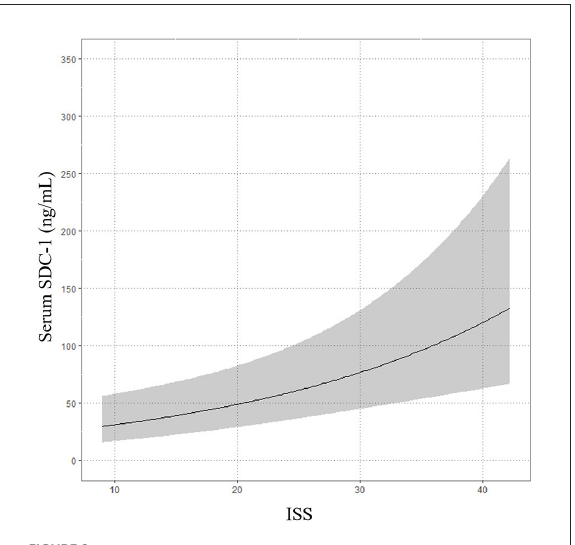
FIGURE2 Association between serum SDC-1 and injury severity score (ISS).